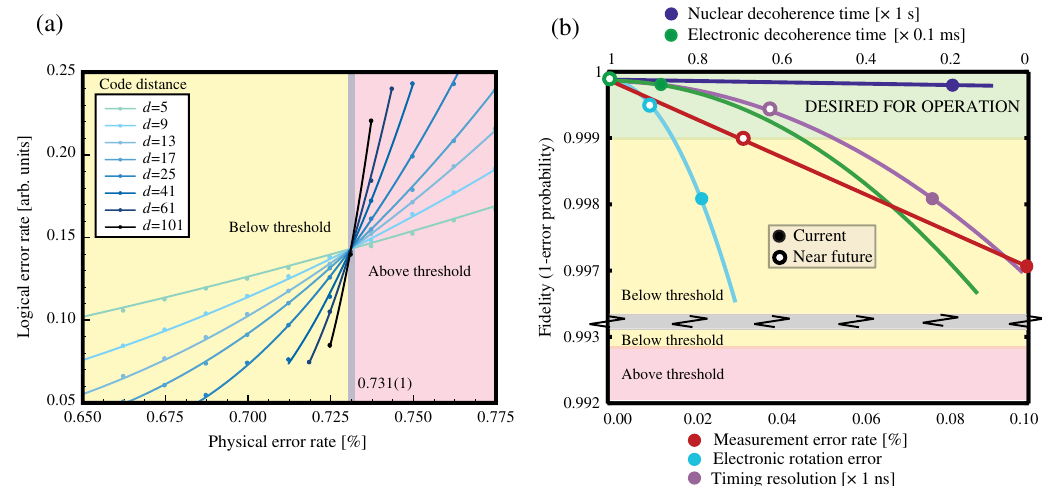
FIG. 6. Fault-tolerant thresholds and required component error rates. (a) Numerical simulation of topological error correction [74]. The logical error rate is plotted as a function of the physical error rate for various code sizes (distances d ), where we assume that all gates and measurements are operating at the same error rate. Each point corresponds to at least 10 4 trials. The value of the physical error rate at the intersection gives the threshold (in this case, approximately 7 . 3 × 10 − 3 ). For physical error rates below this threshold, the logical error rate can be reduced arbitrarily by increasing the code distance. (b) The required fidelity (1-error probability) for each physical parameter. In the Supplemental Material [58] details of the error calculations are shown for various physical parameters. The dots on the lines show the current best accuracy reported, all of which already meet the required accuracy, 99.27%. For a realistic implementation, the gate fidelity should be above 99.9%, corresponding to the green region in the plot. Electronic and nuclear spin coherence times are already in this regime, and the remaining parameters may soon meet the desired accuracy given the rapid development of quantum control of such systems. The fidelity does not converge to unity due to imperfections in the NV −